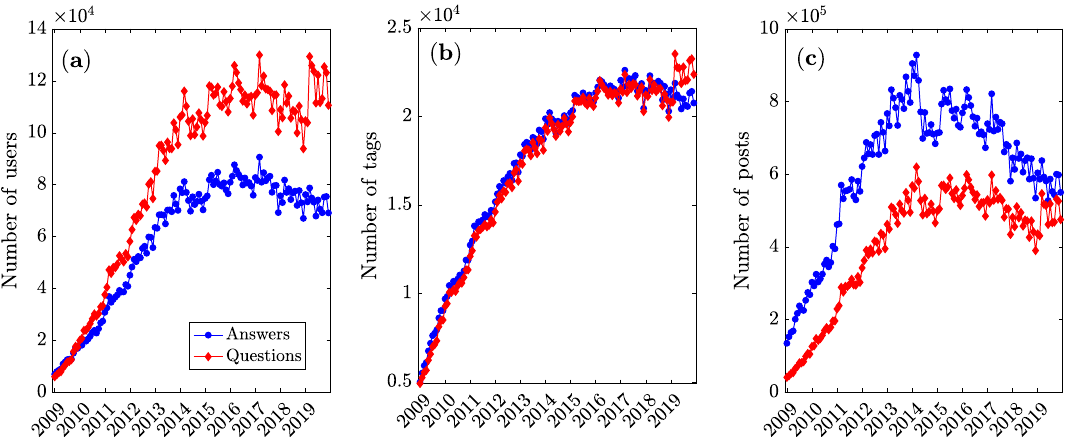
Figure 1. Growth of stack overflow from 2009 to 2019. ( a ) Monthly number of active users. ( b ) Monthly number of tags featured in posts. ( c ) Monthly number of posts. In all panels the blue (red) symbols refer to answers (questions) on Stack Overflow.